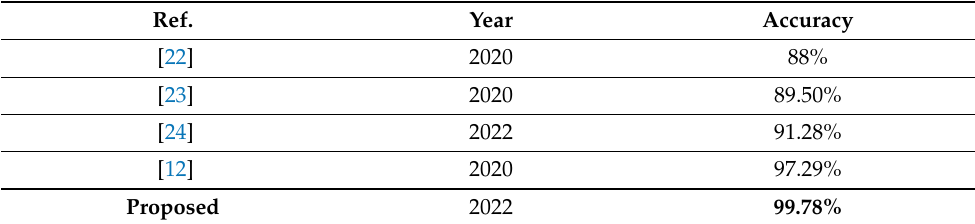
Table 6. Accuracy comparison with existing works.